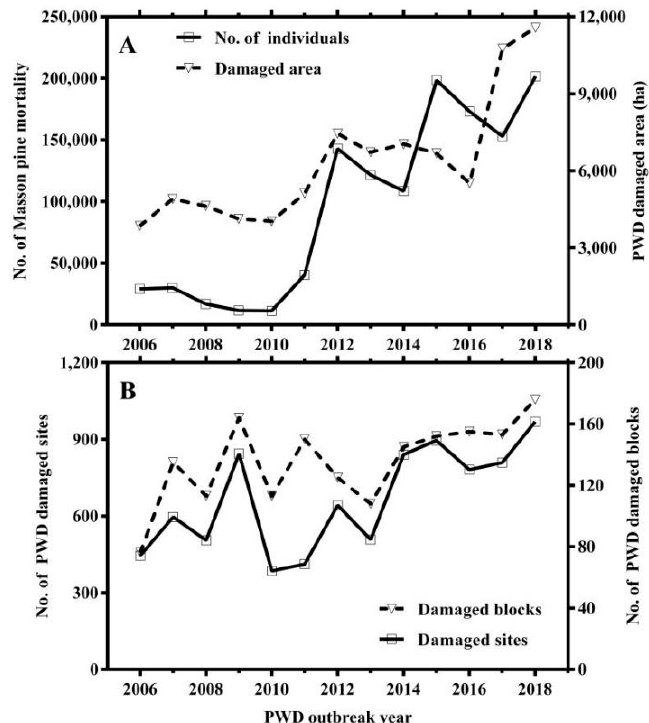
Figure 1. The number of Masson pine mortality and pine wilt disease outbreak areas after the invasion of B. xylophilus in the study area from 2006 to 2018 ( A ). The number of damaged forest blocks and the number of damaged forest sites after the invasion of B. xylophilus in the study areas from 2006 to 2018 ( B ). Table 2. The correlation coefficient matrix for the different pine wilt disease epidemic variables in the study area during 2006 to 2018.